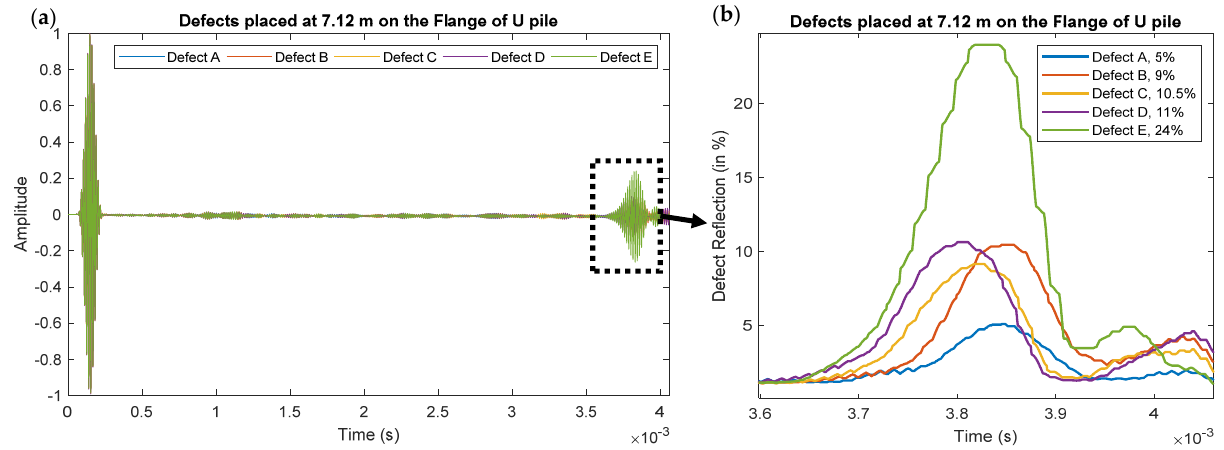
Figure 19. ( a ) Results obtained from the defects placed at 7.12 m on the flange of the U-pile. ( b ) Defect reflection results from the respective defects.